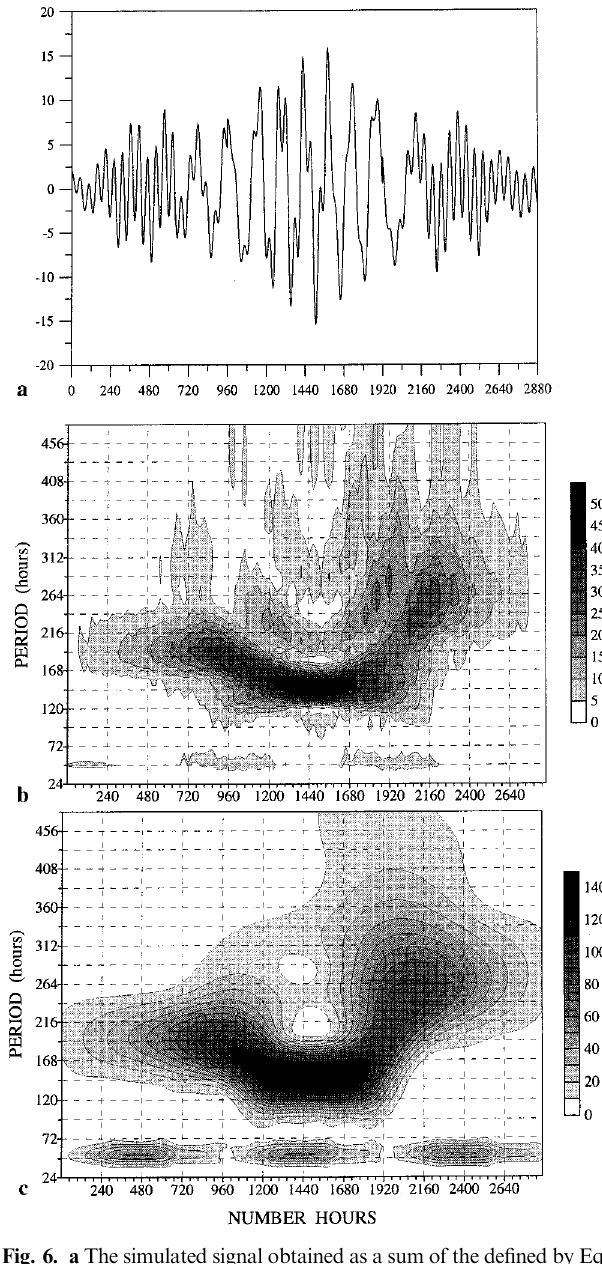
Fig. 6. a The simulated signal obtained as a sum of the defined by Eq. (8) wave packets. b The short-time Fourier transform performed on the simulated data, shown in a , with the length of the segment 720 h which is incremented in 12-h steps. c The Morlet wavelet transform of the simulated signal, presented in